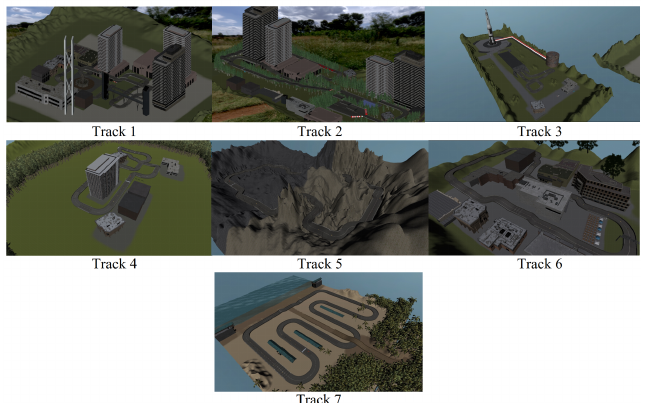
Figure 11. Tracks proposed for the virtual environment, each of the tracks incorporates various static and dynamic elements.